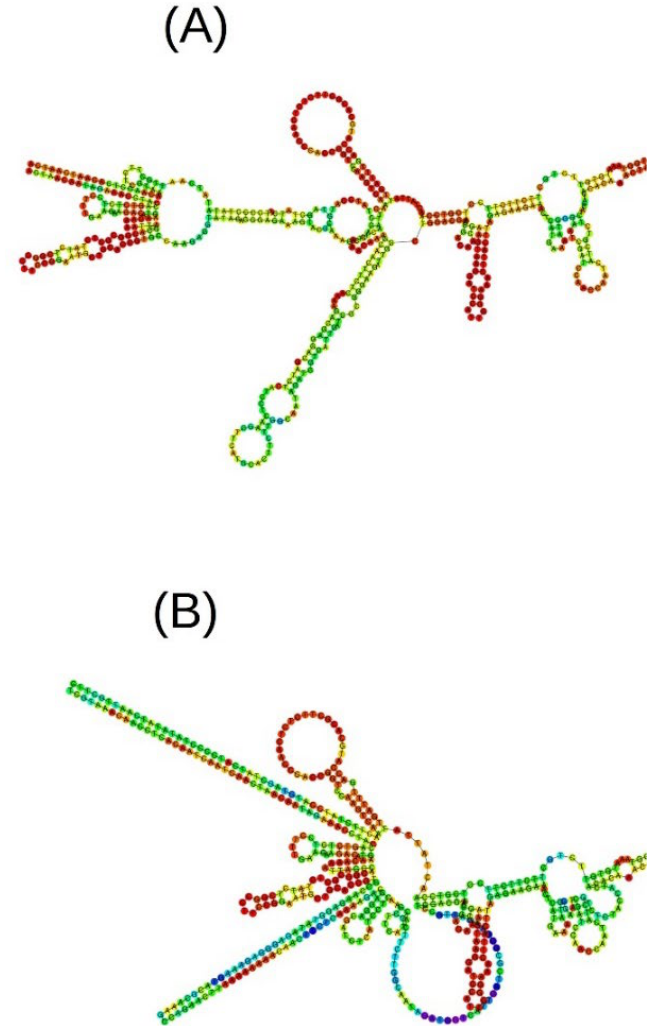
Figure 4. Part of a predicted RNA structure of the normal ( A ) and mutant ( B ) MYBL2